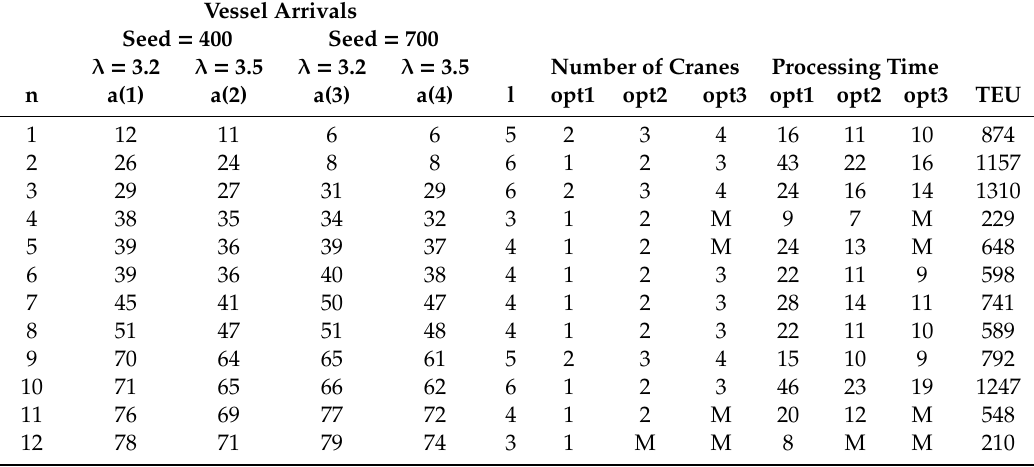
Table A1. Input data for the integrated BAP and QCAP